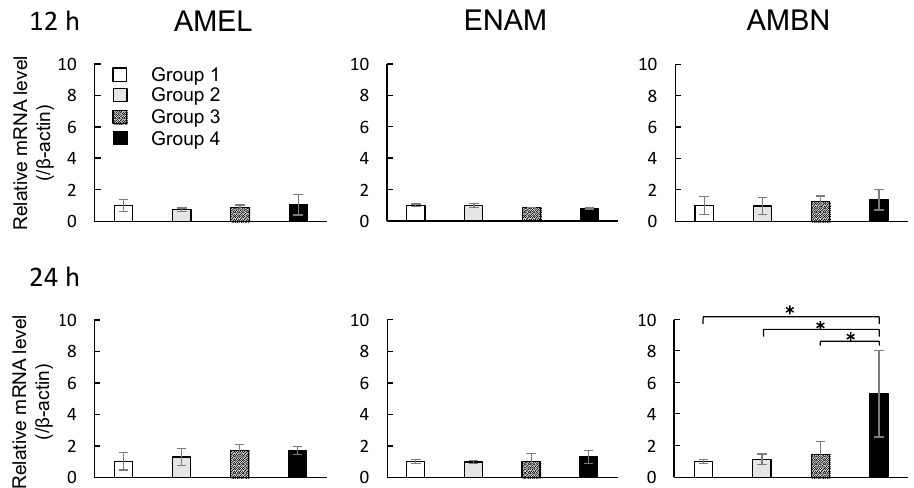
Figure 3. Effects of MNPs and/or magnetic force on the expression levels of AMEL , ENAM , and AMBN in cultured DECs examined by real-time reverse transcriptase polymerase chain reaction (RT-PCR). Real-time RT-PCR data were normalized to the expression levels of β -actin mRNA. Independent experiments were repeated twice. Data represent the mean ± standard deviation (SD) of triplicate samples. * p < 0.05, ANOVA.